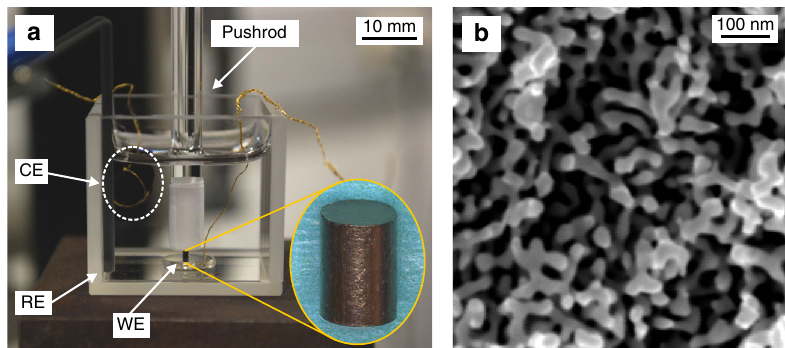
Fig. 3 In situ setup for compression tests under potential control. a Nanoporous gold (NPG) sample (inset) forms the working electrode (WE) and is loaded by a glass rod. CE and RE: counter and reference electrodes. b Scanning electron micrograph of the